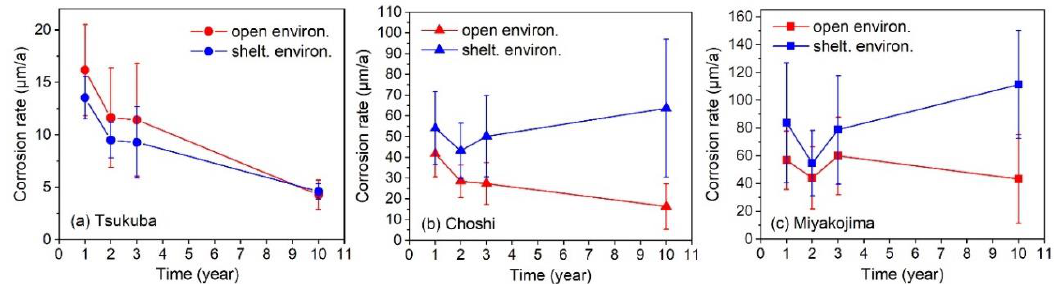
Figure 1. Mean corrosion rate of 13 different low-alloy steels versus exposure time. All the specimens were tested under the open and sheltered environments at the exposure test site ( a ) Tsukuba, ( b ) Choshi and ( c ) Miyakojima, individually.